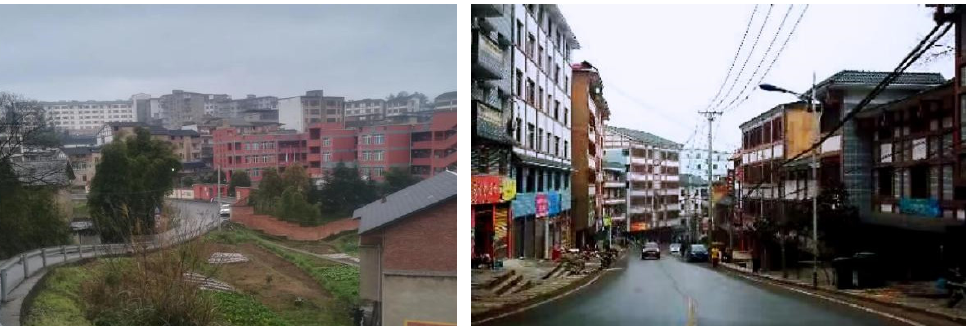
Figure 8. Provincial Highway 105 and Anzhen Village on both sides (source: Taken by the author).